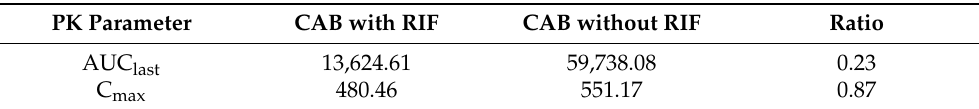
Figure 7. Cabozantinib plasma concentration time profiles in linear ( A ) and semi-logarithmic ( B ) representation after a single oral dose of 140 mg Cabozantinib (capsule formulation) without and with rifampin co-administration. Observed data are shown as dots. Population simulation ( n = 100) geometric means are shown as lines; the shaded areas represent the predicted population geometric SD. Table 2. Comparison of AUC last and C max for the administration of CAB, given either alone or in combination with its perpetrator RIF.